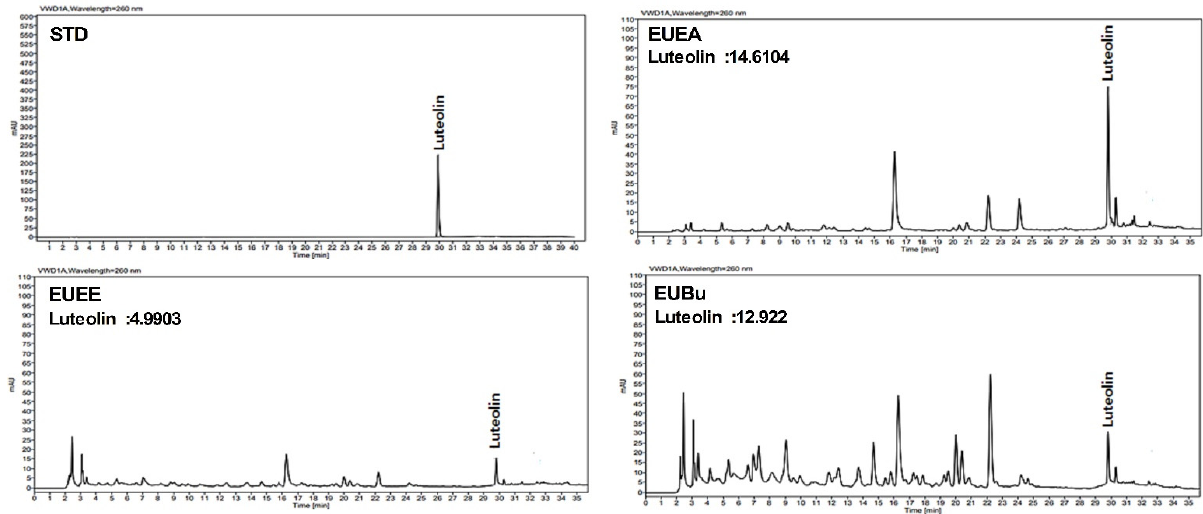
Figure 1. HPLC analysis of EUEE, EUEA, and EUBu. HPLC chromatograms of standard compound (STD) and EU extract and fraction samples. The peak in the HPLC chromatogram indicates luteolin.